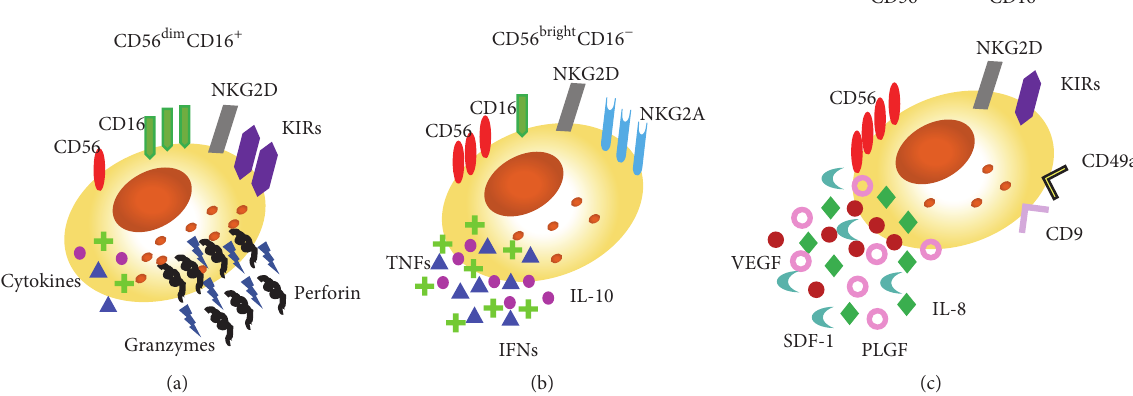
Figure 1: Different human NK subsets. Three different NK subsets have been characterized on the basis of distinctive surface antigen expression and described as (a) CD 56 dim CD16 + that represents the conventional cytotoxic NKs, characterized by the high release of perforin and granzymes; (b) CD 56 bright CD16 − that are able to release a large amount of cytokines; (c) CD 56 superbright CD16 − that are able to produce proangiogenic factors, including VEGF, IL-8, and SDF-1 and are characterized by the expression of specific surface markers as CD9 and